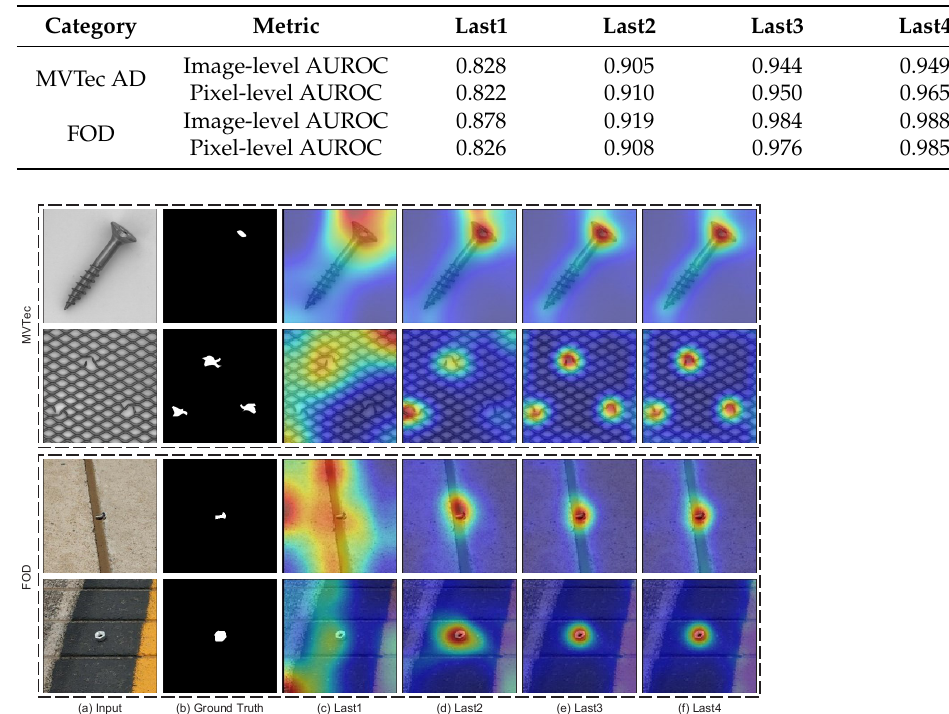
Table 5. The results of MSFI on the MVTec AD and FOD datasets with different hierarchical features. Image-level AUROC represents the average AUROC of all the classes for anomaly detection. Pixel- level AUROC represents the average AUROC of all the classes for anomaly localization.